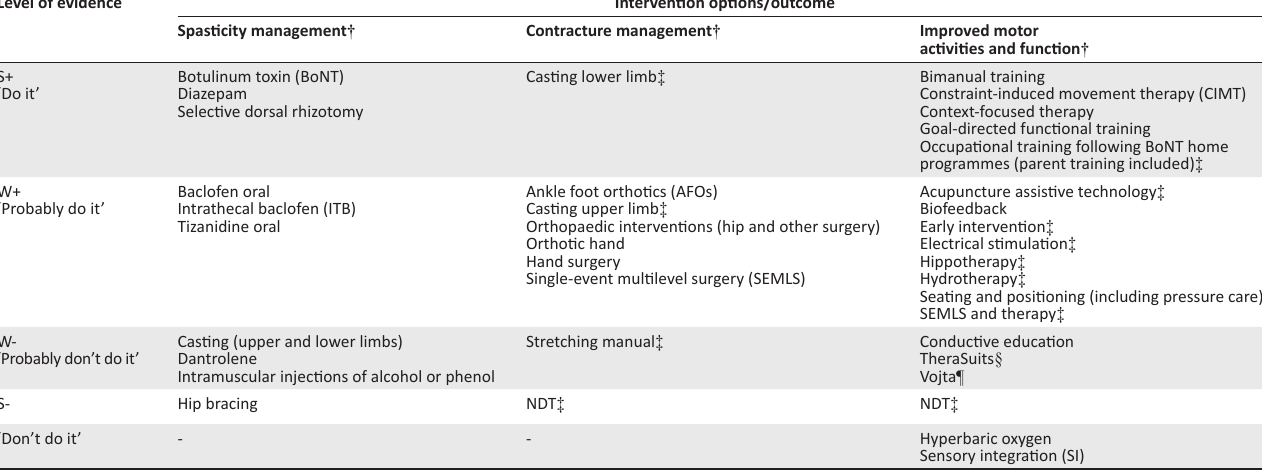
TABLE 1: Levels of evidence for a sample of pain management intervention options related to the three categories of expected outcomes from Novak et al. (2013). Level of